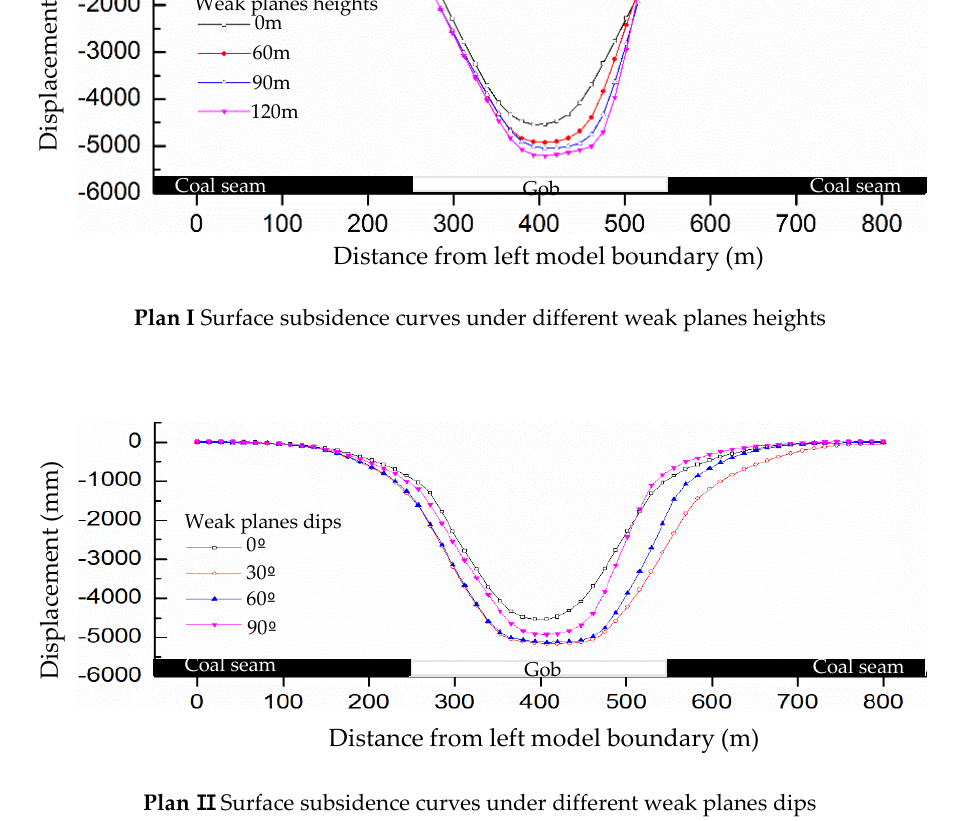
Figure 11. Surface subsidence curves under different types of weak planes.